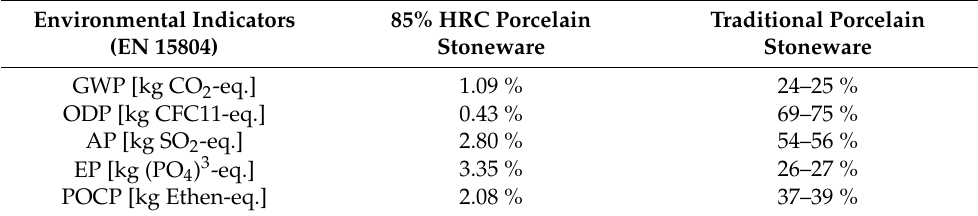
Table 6. Relative contribution of environmental impact indicators between 85% HRC spray-dried powder production and an average traditional spray-dried powder production, as a percentage of the overall contribution of the A1, A2, A3 manufacturing process (raw materials supply, transport and manufacturing, respectively).